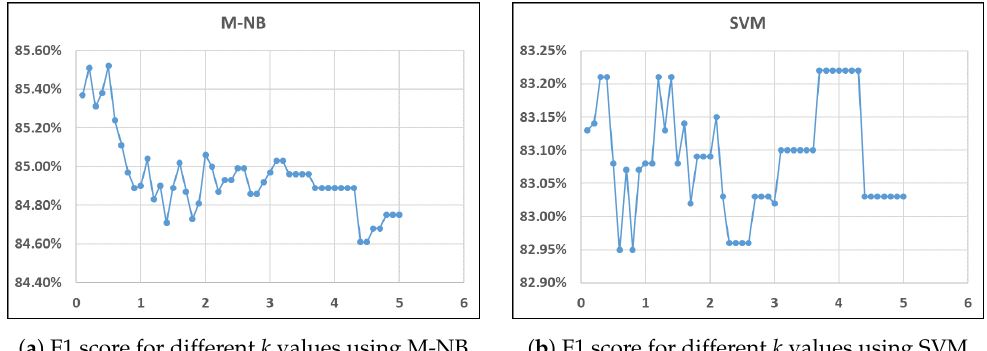
Figure 7. Results of all considered k values for SenWave dataset.